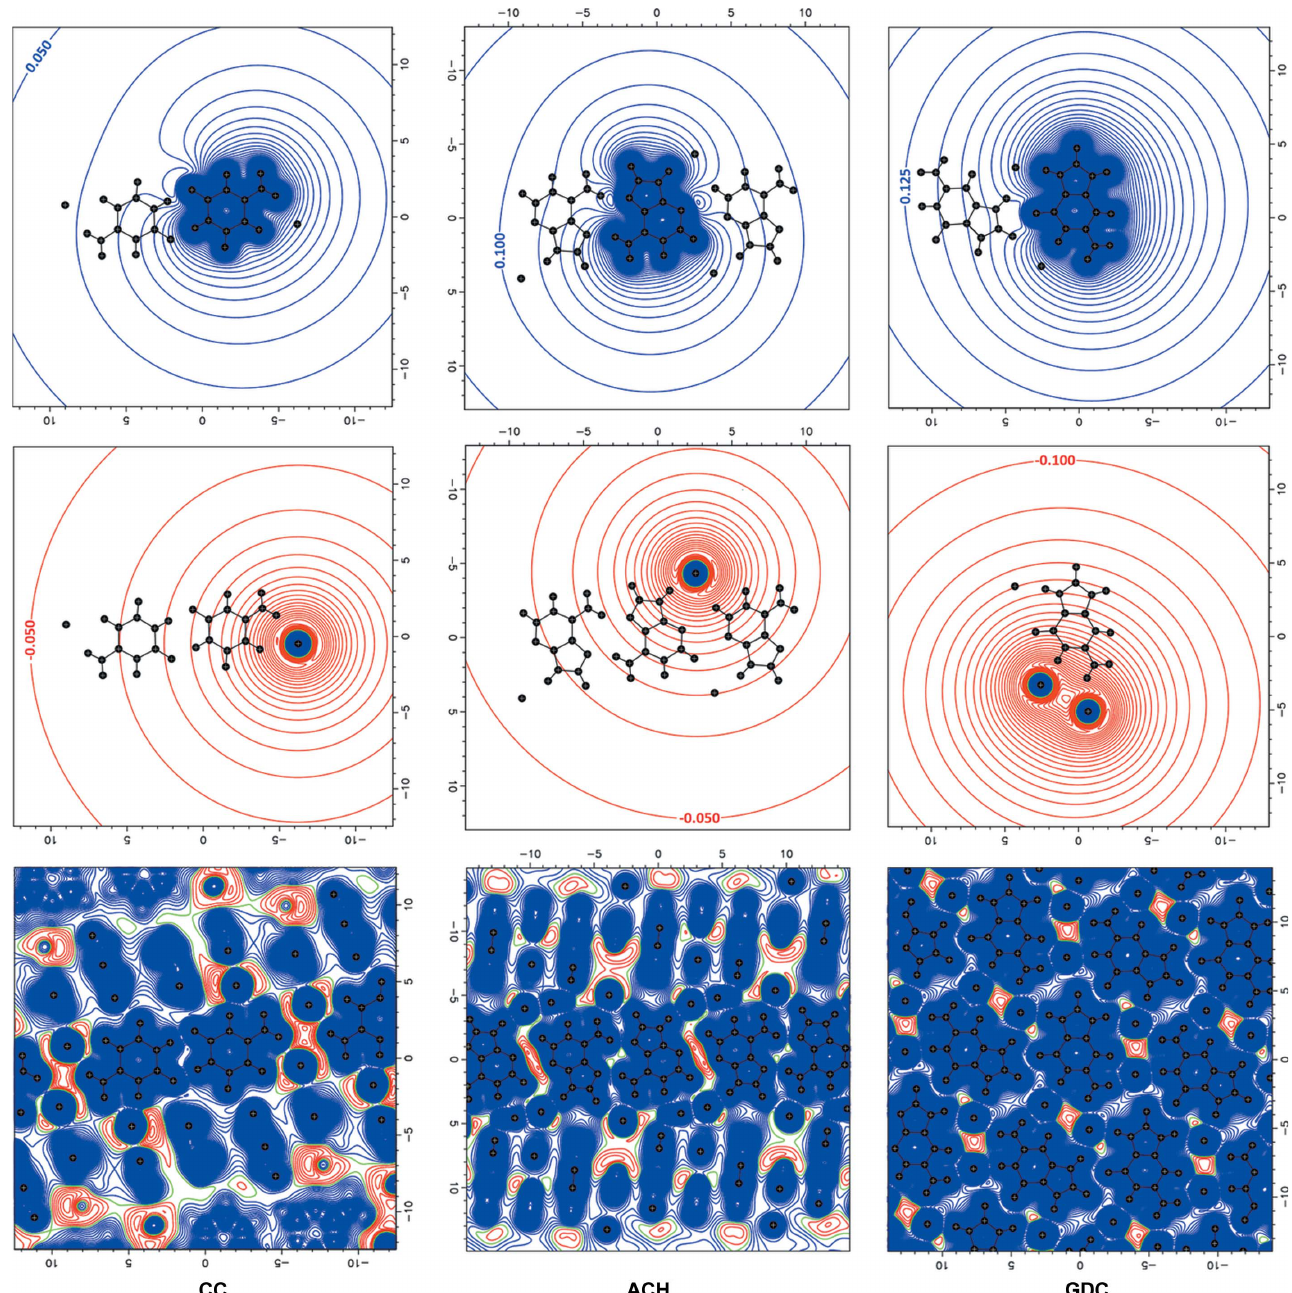
Figure 8 Electrostatic potentials (e A˚ (cid:4) 1 ) of (top) protonated nucleobase cations, (middle) chloride anions and (bottom) entire crystals from experimental charge densities in the plane of the nucleobase. Contour lines are drawn every 0.025 e A˚ (cid:4) 1 . Blue denotes positive values, red negative and green